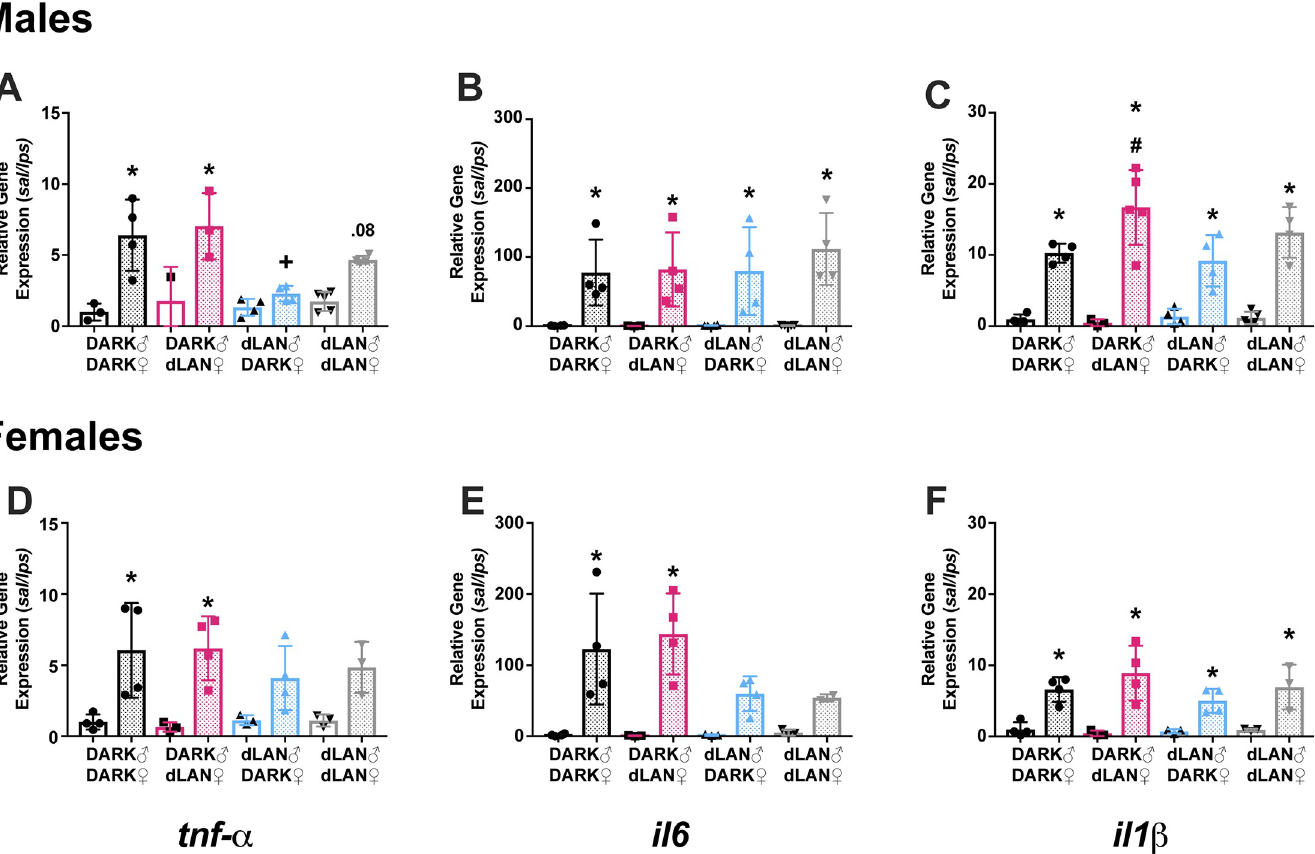
Fig 3. Preconception dLAN altered splenic cytokine gene expression in an offspring sex-specific manner. Splenic tnf- α , il-6 , and il-1 expression 3 hours post-LPS challenge in males (A-C) and females (D-F). Open bars represent saline, dotter bars represent LPS. N = 3-5/group/sex; error bars represent SD. #, P < 0.05 Dark-dLAN LPS vs Dark-Dark LPS and dLAN-Dark LPS; +, P < 0.05 dLAN-Dark LPS vs Dark-Dark LPS and Dark-dLAN LPS; � , P < 0.05 saline vs LPS.